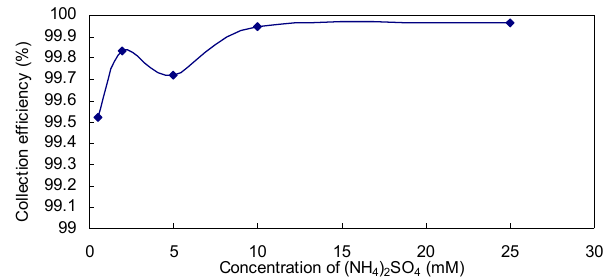
Fig. 4. Aerosol penetrating rate through the WAD versus (NH 4 ) 2 SO 4 concentrations used for particles generation.